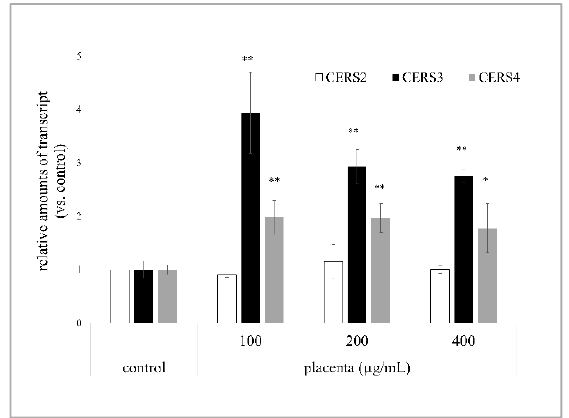
Figure A1. Expression of ceramide synthase in human keratinocyte cells (HaCaT) cells after porcine placenta extract application.